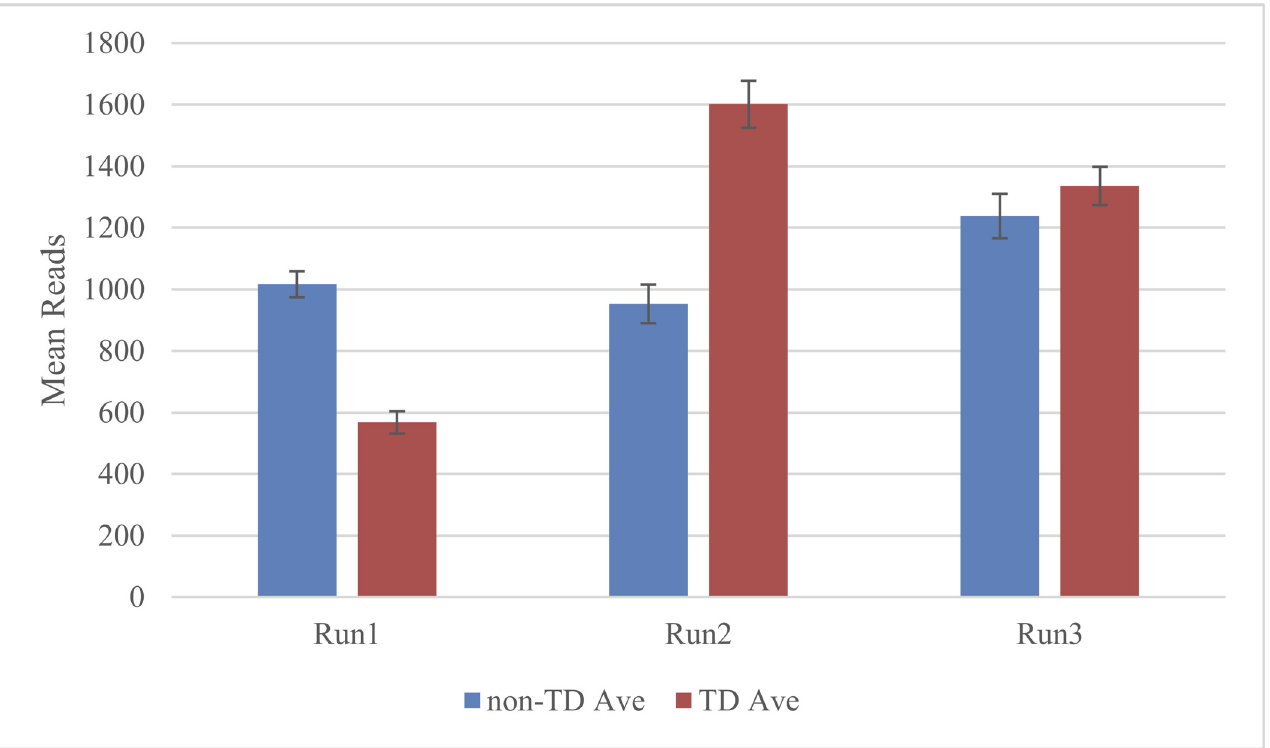
Fig 6. Average number of reads per marker in non-TD (blue column) and TD PCR (red column). Standard errors are shown as error bars on top of columns. Samples were run using the primer combination of 8 nM and 16 nM.